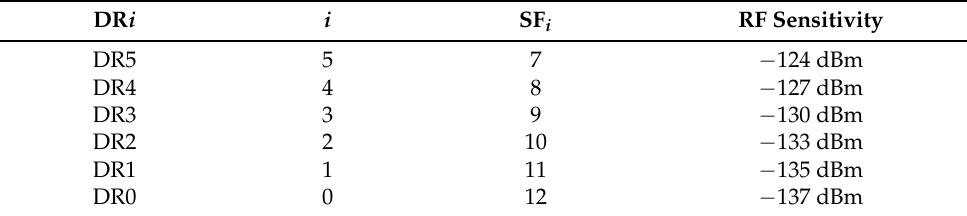
Table 3. RF Sensitivity for the SX1272 devices.